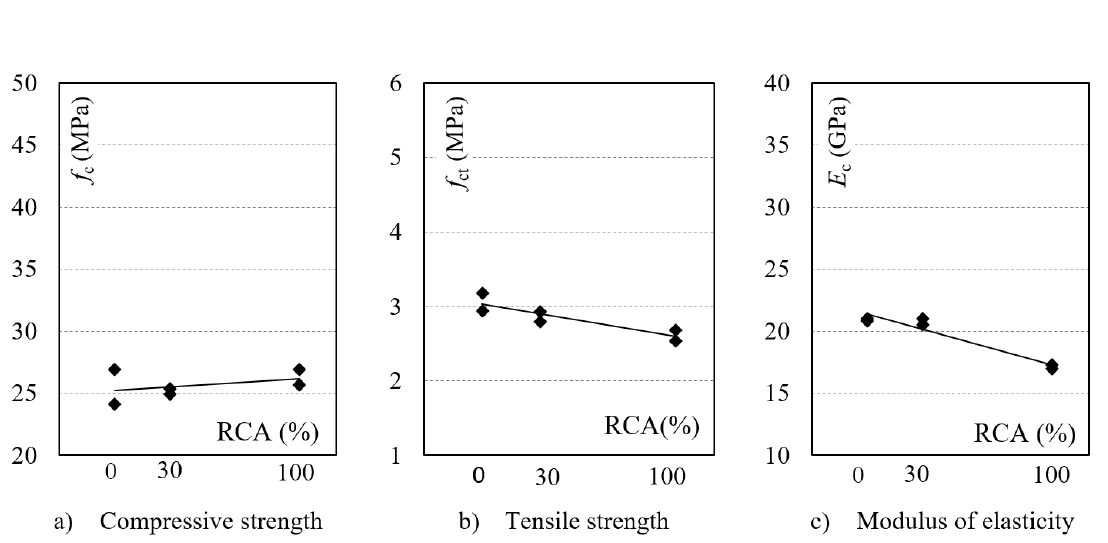
Figure 5 – Results of characterization